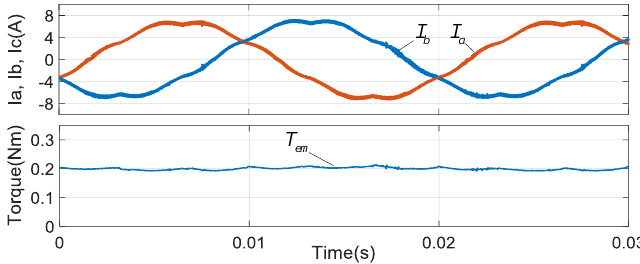
Figure 8. Test waveforms at the speed of 1500r/min with SWC.